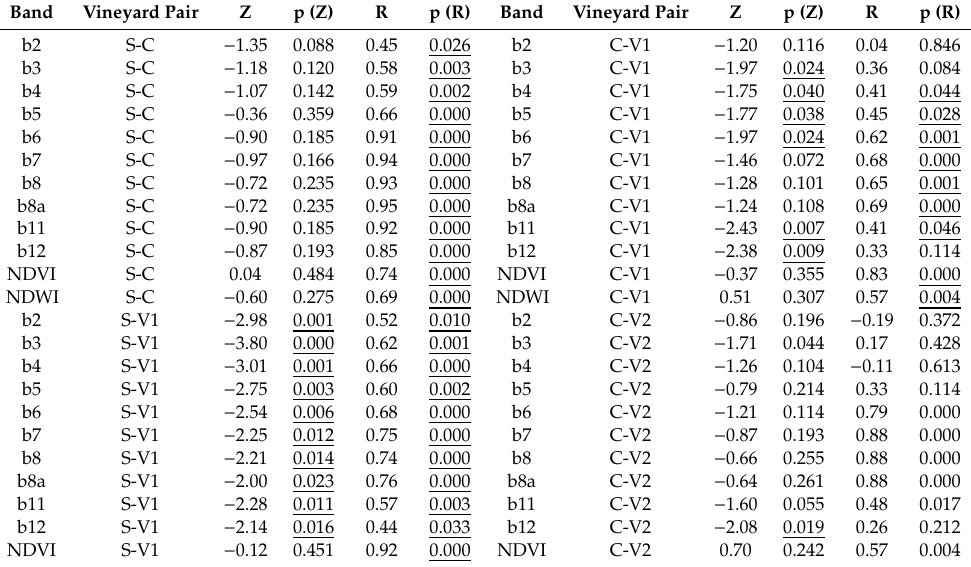
Table 2. Statistic parameters used to test similarity of temporal profiles of vineyards mean spectral responses (bands and indices). Significance of di ff erences among profiles was tested by Wilcoxon rank-sum approach (Z statistic with correspondent probability p (Z)) applied to all possible vineyard pairs. Similarity of temporal profiles was also tested by Pearson’s correlation (R with correspondent probability p (Z)). Underlined numbers indicate significant di ff erences and correlation at p <